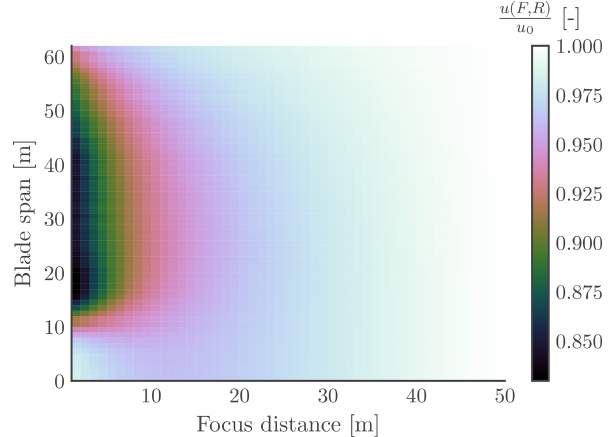
Figure 3. Normalized longitudinal inflow wind speed ( u ( F,R ) u function of focus distance ( F ) and blade span position ( R ), with an undisturbed inflow wind speed u 0 = 13ms − 1